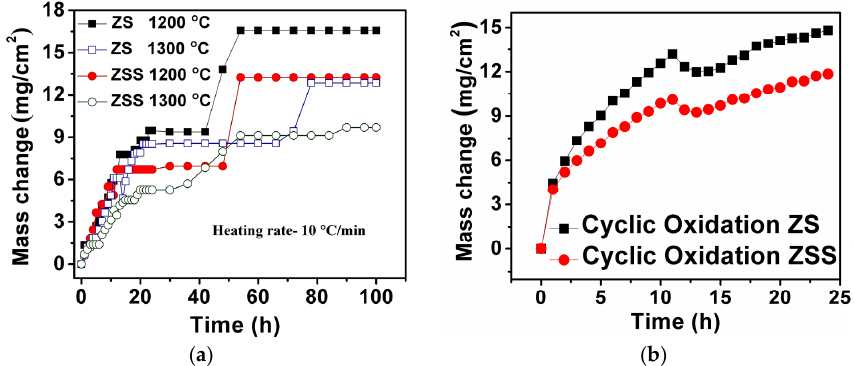
Figure 2. Plots of change in mass against time obtained from ( a ) isothermal; and ( b ) cyclic oxidation tests carried out on ZS and ZSS for duration of 100 h at 1200 and 1300 °C.